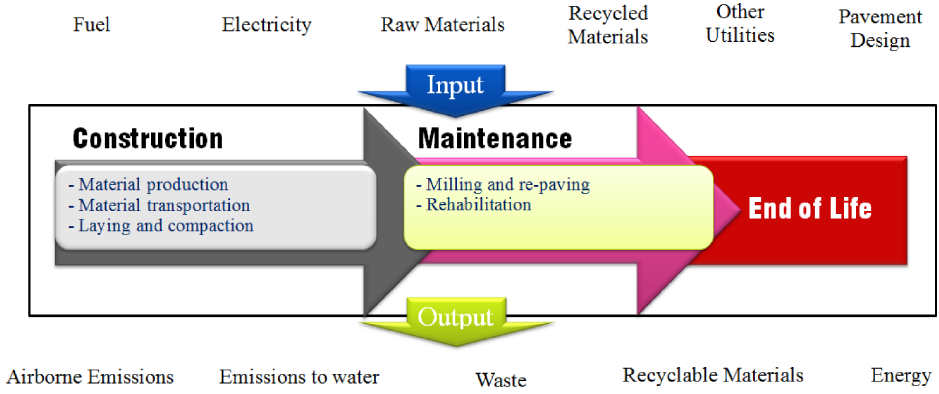
Fig. 1. Life cycle assessment framework for asphalt